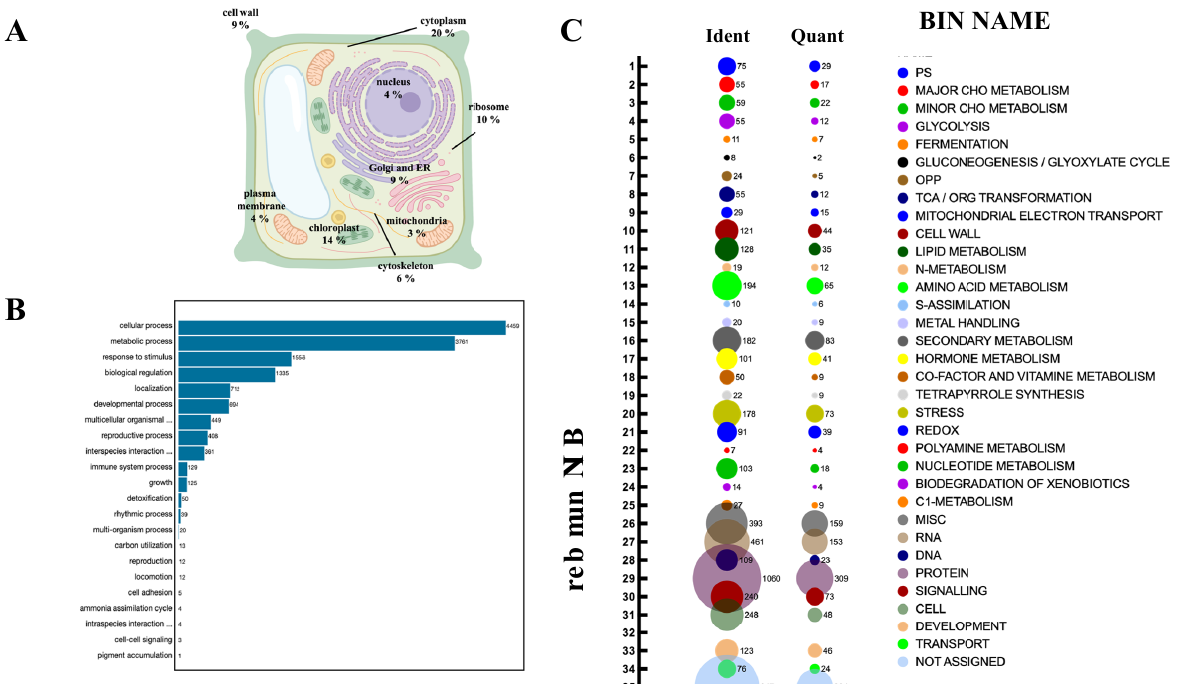
Figure 3. Subcellular localization and functional classification of the persulfidated proteins in root tissues. ( A ) Subcellular distribution of the persulfidated proteins classified by GO analysis (UniProt) as being related to cellular components. ( B ) GO classification (UniProt) of proteins related to biological processes. ( C ) Bubble plot of the functional classification of the identified (Ident) and quantified (Quant) proteins according to the plant-specific database